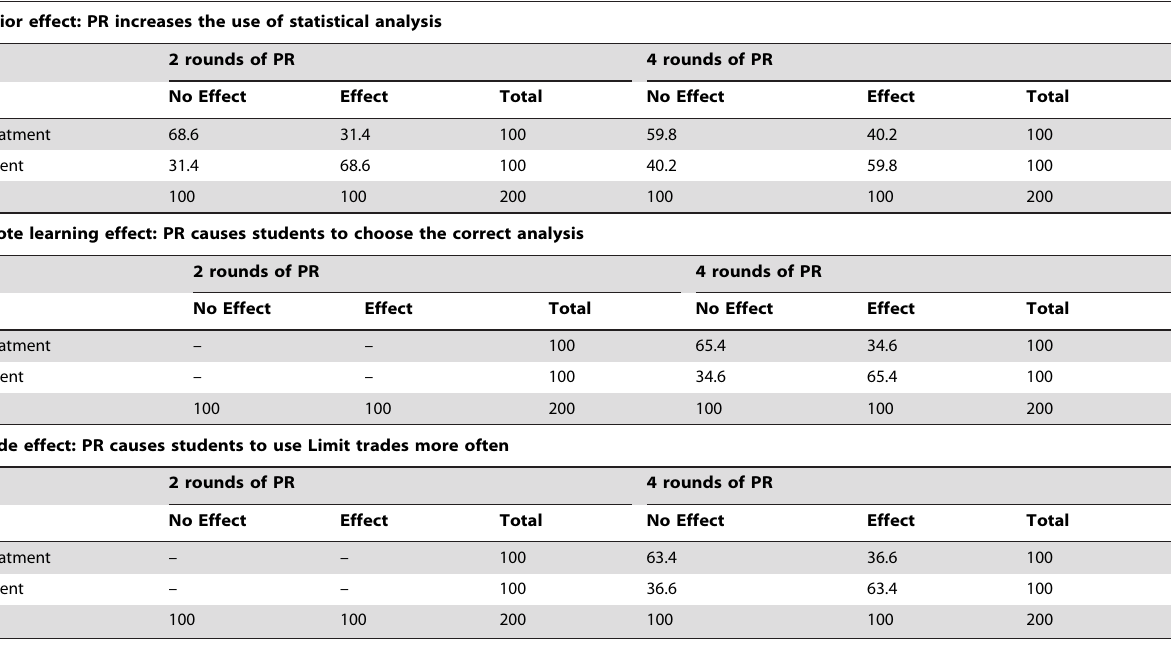
Table 3. Binomial Effect Size Display (www.wessa.net/rwasp_PRexperiment.wasp).